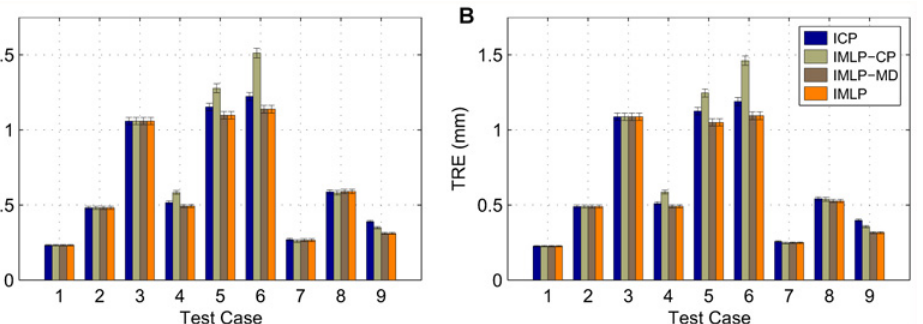
Fig 2. Registration errors for registering a mesh target shape. (Experiment 2). Source shapes were randomly generated from a mesh model of a human hip (Fig. 1A), misaligned by (A): [15, 30] mm / degrees and (B): [30, 60] mm / degrees, and registered back to the mesh. The test cases represent the different noise models used to generate noise on the source shape (Table 4). For each test case, 300 randomized trials were conducted, with successful registrations being used to compute an average target registration error (TRE). The error bars provide approximate standard deviations of the reported average TRE values. The proposed IMLP algorithm was evaluated relative to standard ICP [1] and relative to near-comparisons of GTLS-ICP [10] and A-ICP [12] using IMLP-CP and IMLP-MD, which modify IMLP ’ s most-likely match criteria to that of closest-point and Mahalanobis-distance matching,